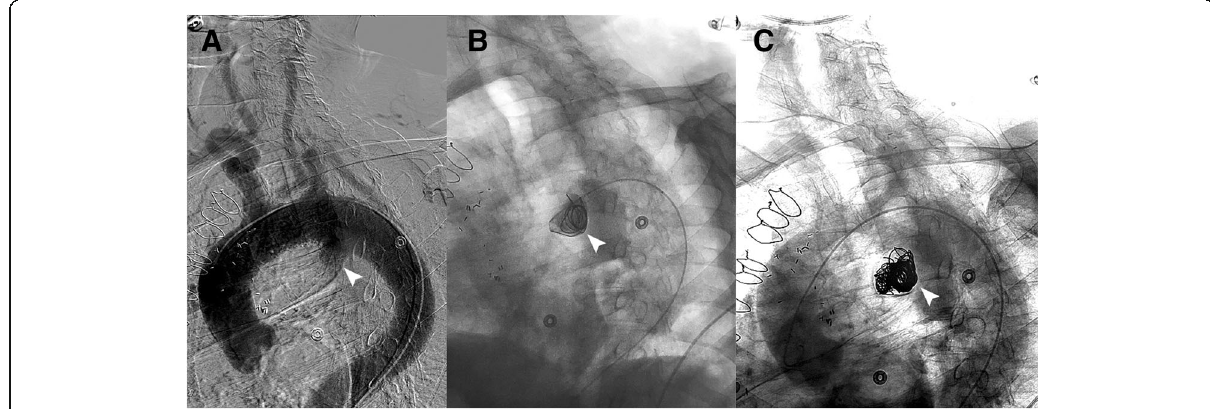
Fig. 3 a Arch aortogram pre-embolization showing the DAD (arrowhead). b Embolization – initial coil placement. c Arch aortogram